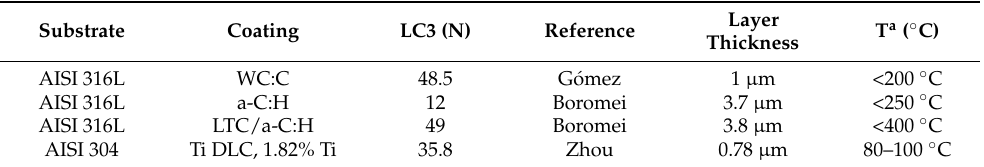
Table 4. Experimental data derived from the scratch test for different coatings over a stainless steel substrate [10,35].